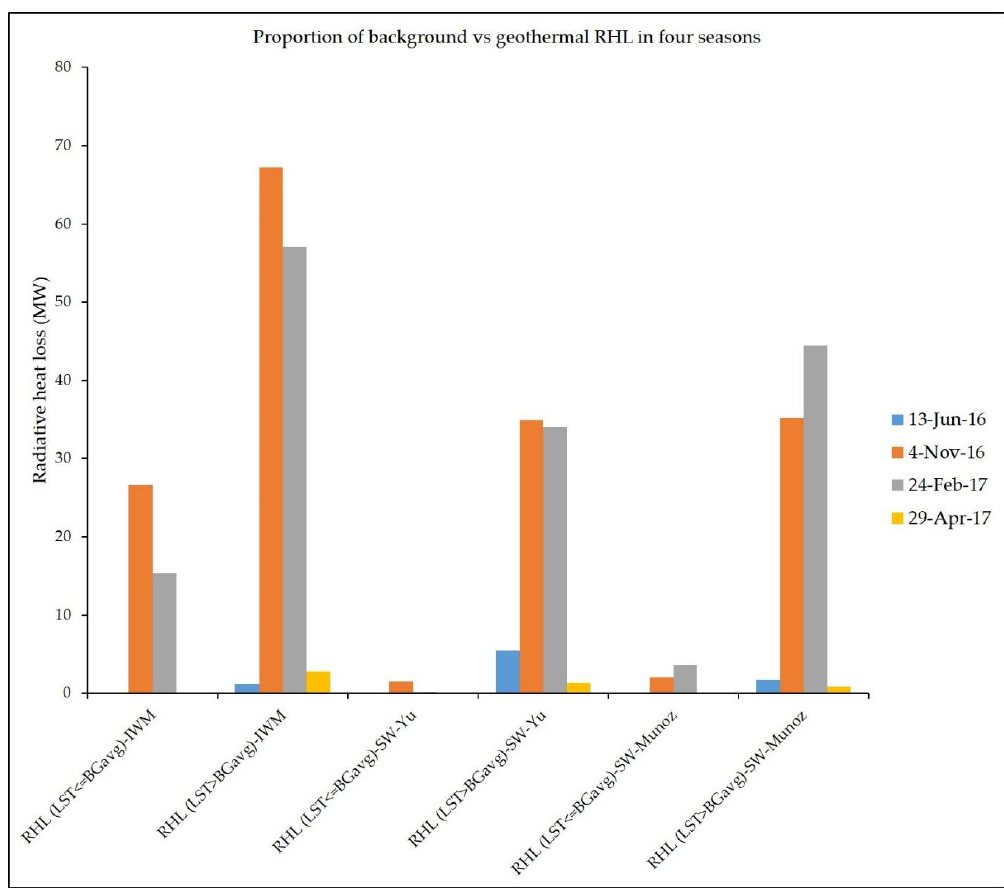
Figure 21. Plot shows RHL contributed by pixels with LST < or = to the background (average) vs. LST < background (geothermal) of the study area from the four seasons. RHL—radiative heat loss; LST—land surface temperature; BGavg—background LST (average); IMW—improved mono-window algorithm; SW-Yu—split-window algorithm of Yu et al. [19]; SW-Muñoz—split-window algorithm of Jiménez-Muñoz et al. [20].